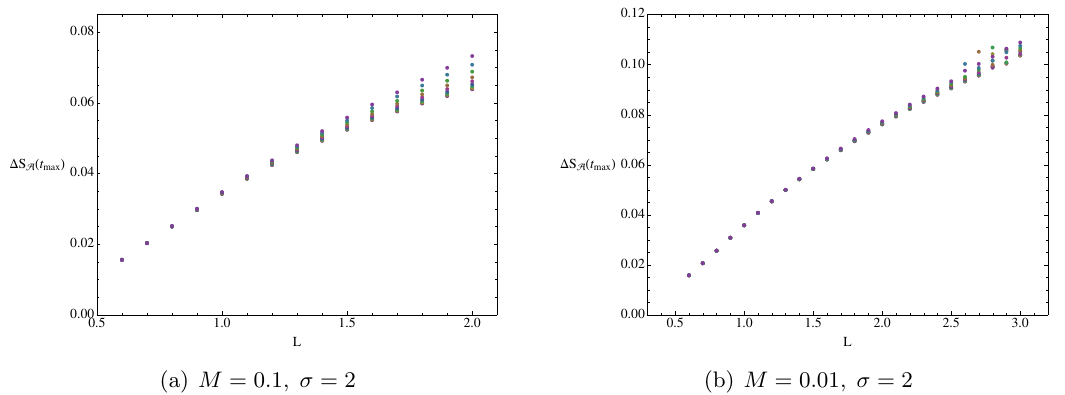
Figure 2 . The maximum of (cid:1) S A ( t ) as a function of strip width L for (cid:11) = 0 : 1. Note that all charged con(cid:12)gurations have been included in the same (cid:12)gure to illustrate the weak dependence of the entanglement entropy with respect to